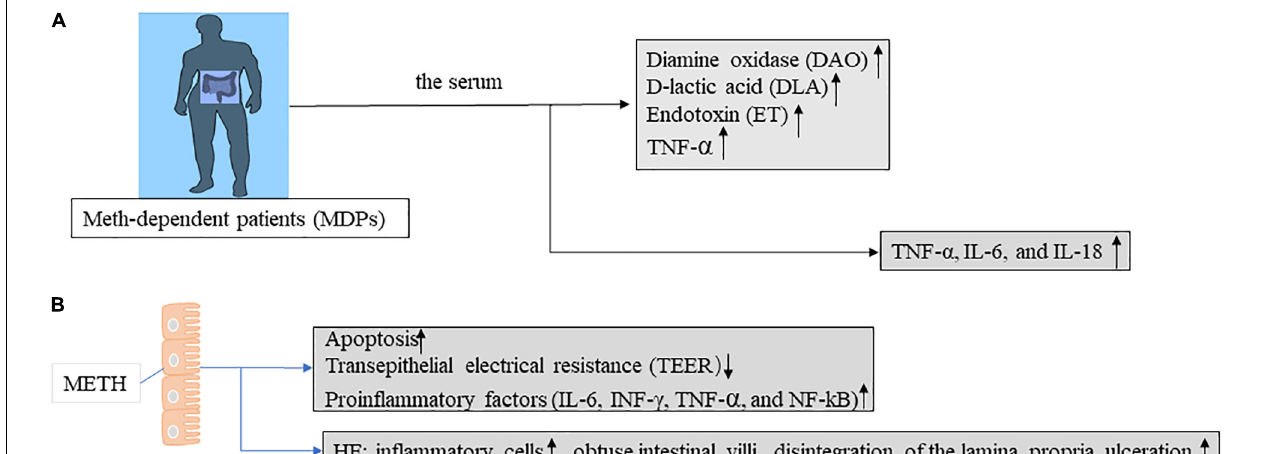
FIGURE 2 | Intestinal barrier function was evaluated in mice and humans in the context of METH treatment. (A) Intestinal mucosal injury, intestinal wall permeability, and bacterial translocation are assessed by determining the serum levels of diamine oxidase (DAO), D -lactic acid (DLA), and endotoxin (ET) in Meth-dependent patients (MDPs). Abnormal levels of all these indicators reflect intestinal barrier dysfunction. (B) Intestinal epithelial cells of methamphetamine-treated mice are evaluated for intestinal barrier function by apoptosis, TEER, proinflammatory factors, and HE staining. Abnormal levels of all these indicators reflect intestinal barrier dysfunction.